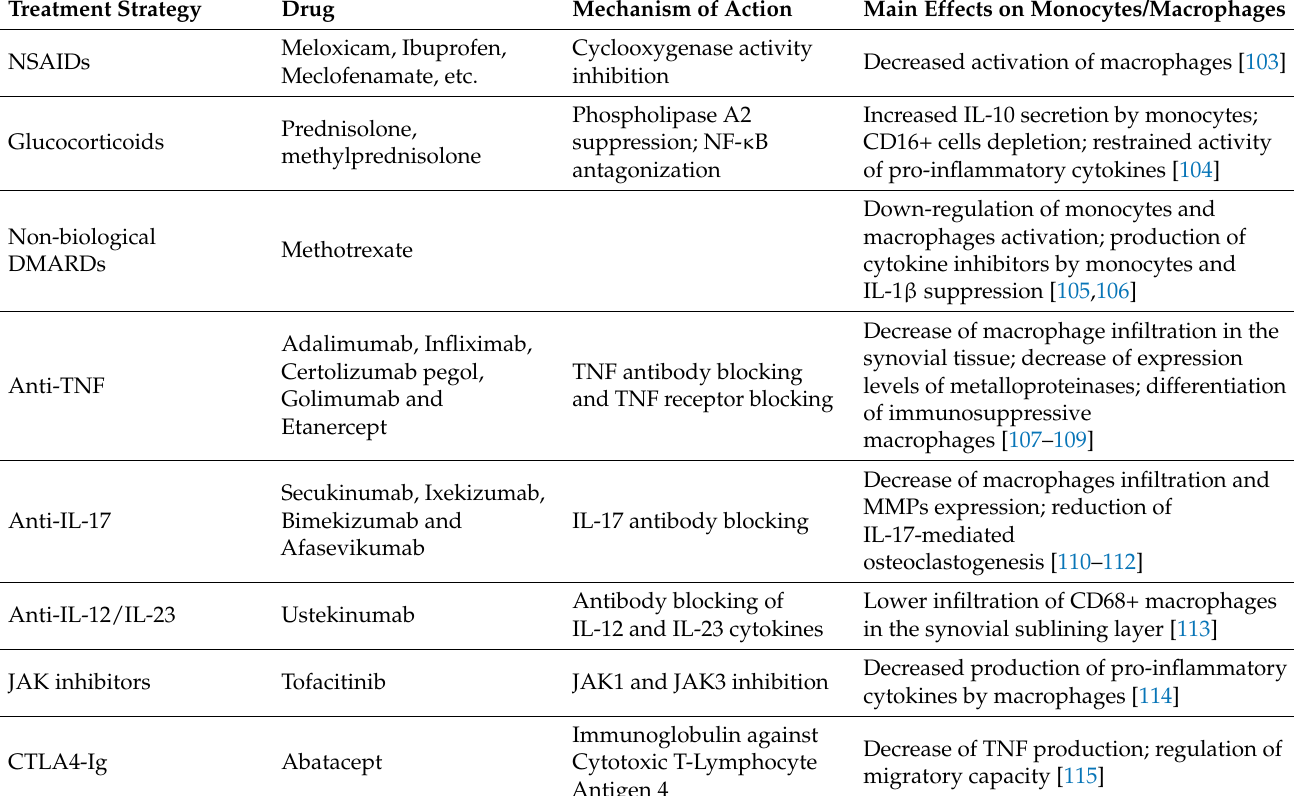
Table 1. Treatments in SpA, mechanisms of action and its effects on monocytes and